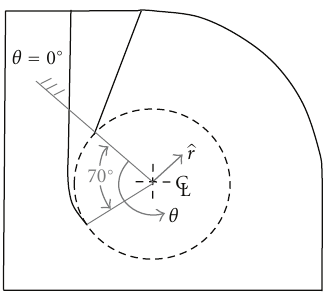
Figure 8: Water superficial velocity vectors at midspan of domain nozzle